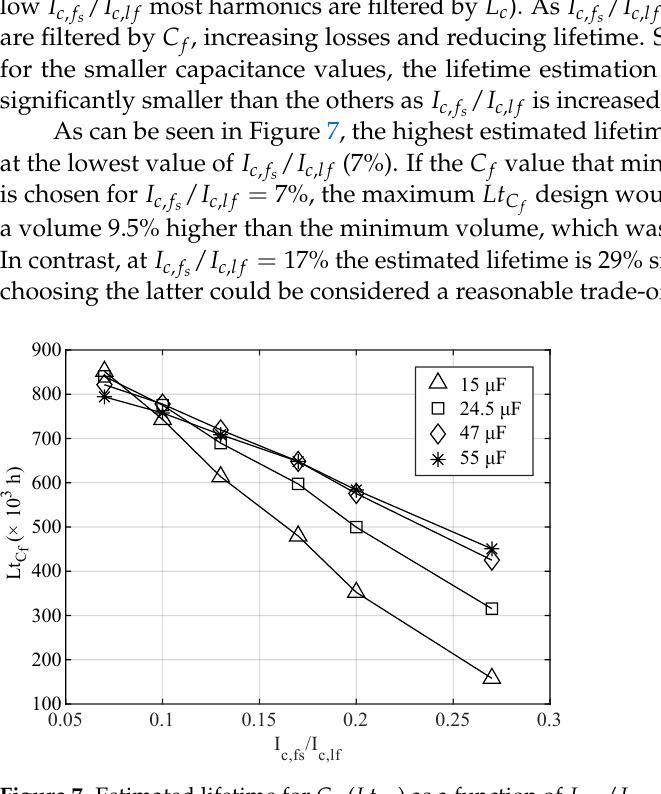
) as a function of I c , f f